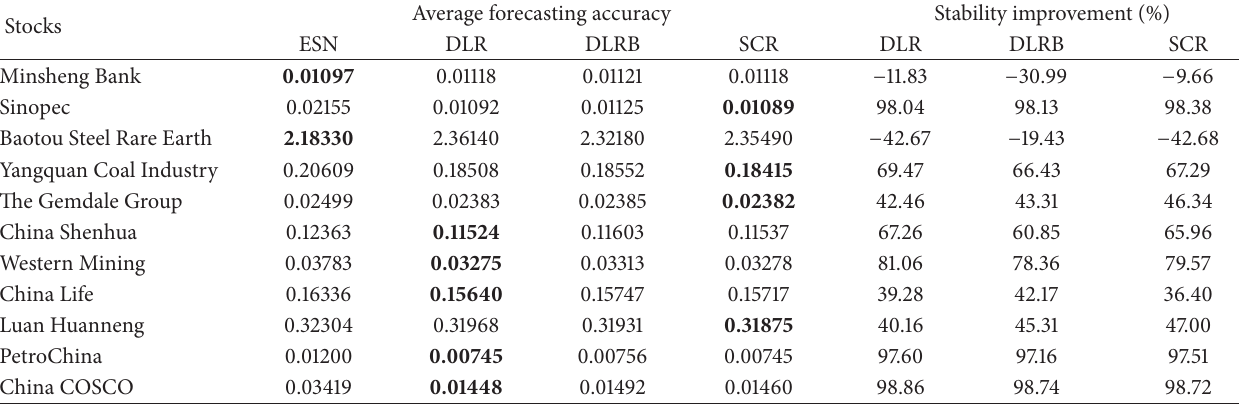
Table 4: Comparison of ESN and three deterministic ESN models by average forecasting accuracy (MSE) and stability improvement (%).